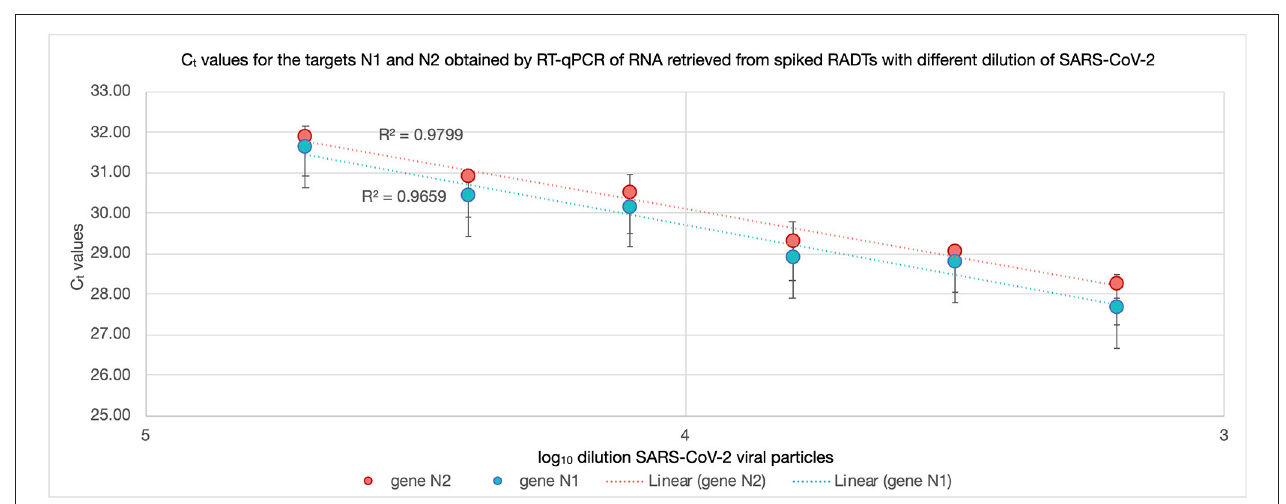
FIGURE 2 | C t values for N1 and N2 of RNA recovered from RADTs spiked with different concentrations of SARS-CoV-2 viral particles. The RNA recovered from RADTs spiked with SARS-CoV-2 was detected through RT-qPCR and the C t values ranged between 27.49 and 31.80 for the gene N1 (blue) and 28.19 and 31.91 for the gene N2 (red) reported in the y-axes. The log 10 of the SARS-CoV-2 viral particles dilutions is presented in the x-axes. The R-squared ( R 2 ) values are displayed in the dotted trend lines and the vertical bars on the points represent the standard deviation considering the average of the two C t values recorded for each sample.